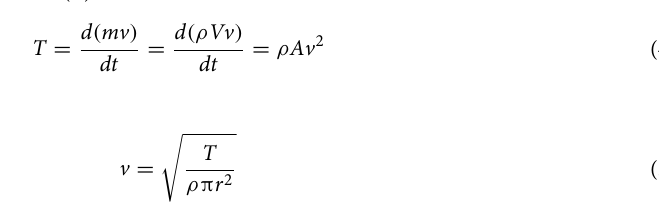
Figure 8. Top view of theRIE array setup mounts for ionic thrust measurements. ( a ) two-RIE toroidal array ( b ) three-RIE toroidal ( c ) four-RIE toroidal array. ( d ) mounted four-blade X15A Guangdong Syma drone; the drone generated a maximum lifting force very close the maximum thrust recorded for the 4-RIE (Fig. 4d). The average of the 10 measurements provided a scale reading of 264.25 mN with a standard deviation of 2.04 mN (0.76%). The axial ionic thrust ( T ) can also be calculated from the fundamental force relation: